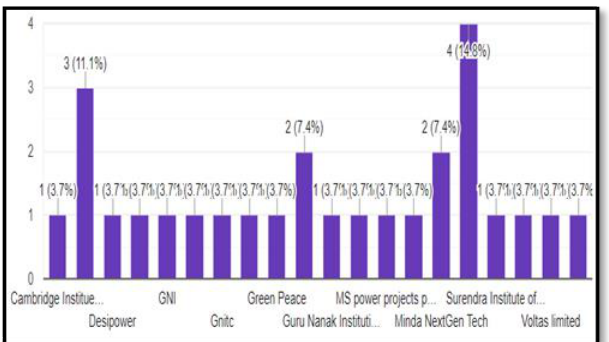
Figure 6. List of Companies working in the field of Microgrids